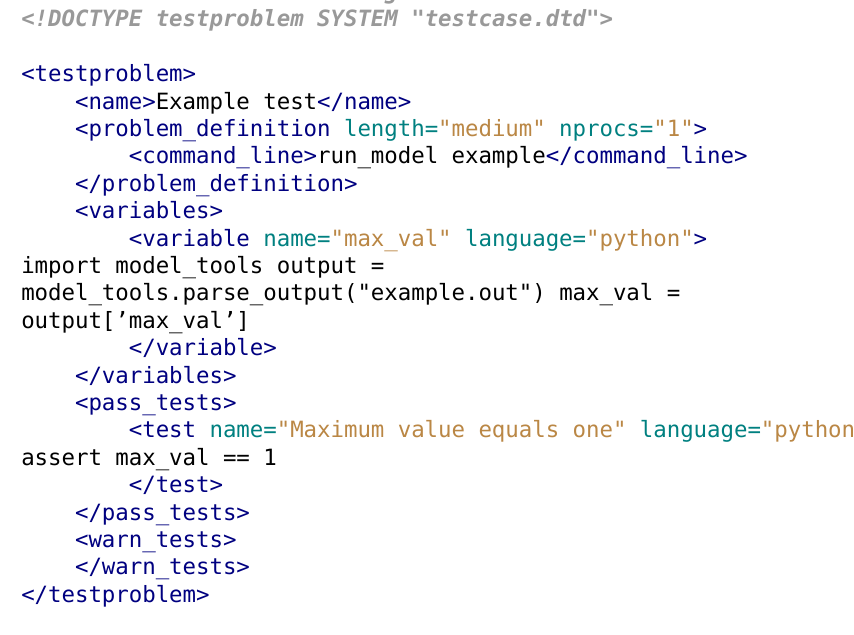
Fig. 2. Example test case, as described in Sect. 3.4. The test is described by an XML file. The command to be executed is recorded in the command line tag. Functionals of the output to be computed are recorded in variable tags. Assertions to be made about the values of the functionals are recorded in test